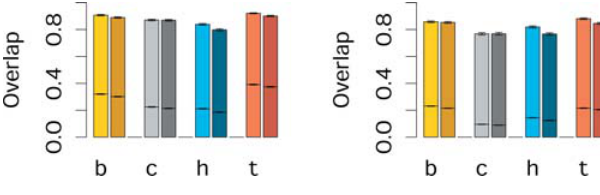
Figure 3. Overlap of Expressed Probes between Species Shown is the overlap of expressed exonic (left, lighter shades) and intergenic (right, darker shades) probes between humans and chimpan- zees in brain (B), lymphoblastoid cell line (C), heart (H) and testis (T) for the positive (left panel) and negative (right panel) chromosome strands. The horizontal lines inside the bars show the overlap expected by chance. The error bars represent 95% confidence intervals based on bootstrapping of 1,000 subsets of exonic and intergenic probes having the same number of probes from each category and the same signal intensity distribution. DOI: